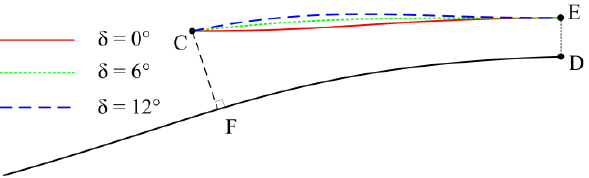
Figure 3. Comparison of the cowl configurations with different cow lip angles.